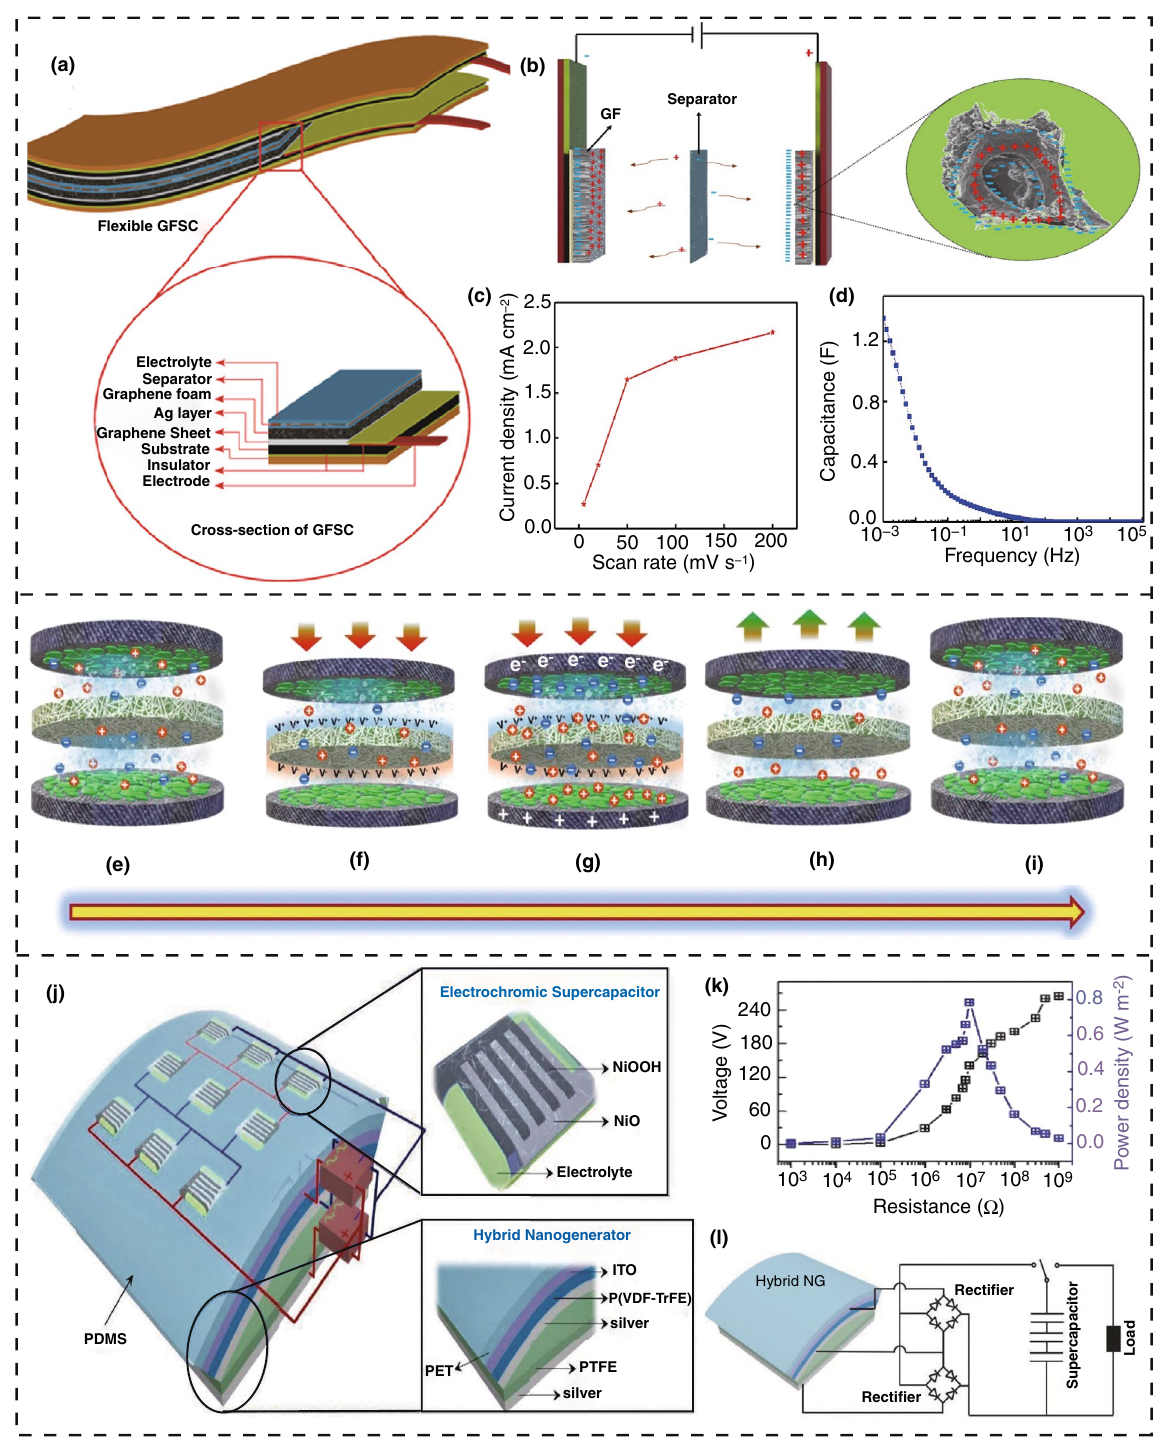
Fig. 10 Self-charging mechanism and supercapacitor performances. a Cross section of graphene foam supercapacitor. b Electrochemical reactions of the electrolyte ions on the surface of the electrodes. c Current density plot with the scan rate. d Capacitance of the fabricated supercapacitor. e Initial state of the siloxene supercapacitor. f Migrating electrolyte ions toward the electrodes due to the piezoelectric effect. g The new equilibrium state after the piezoelectrochemical reaction. h Effect of removing the compression; the disappearance of piezoelectric field. i Returning to the initial state after a complete self-charging cycle. j Schematic of the compact power device with the electrochromic supercapacitors and hybrid nanogenera- tor. k External load effect on the output voltage and power density. l The circuit diagram of rectification of the generated power from the device. Fig- ures reprinted with permission from: a , b , c , d Ref. [126], © 2021 Elsevier; e , f , g , h , i Ref. [127], © 2020 Nature; j , k , l Ref. [131], © 2016